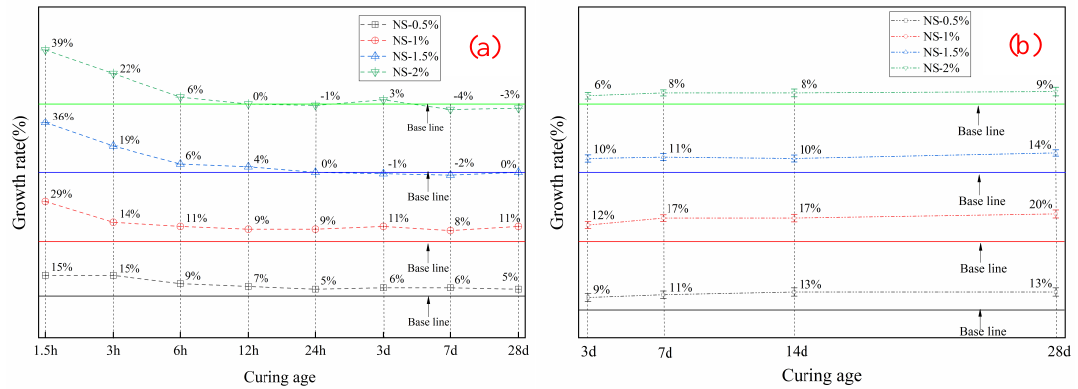
Figure 10. Growth rate of the cement mortar compressive strength: ( a ) HBSAC cement; ( b ) P·O 42.5 cement.